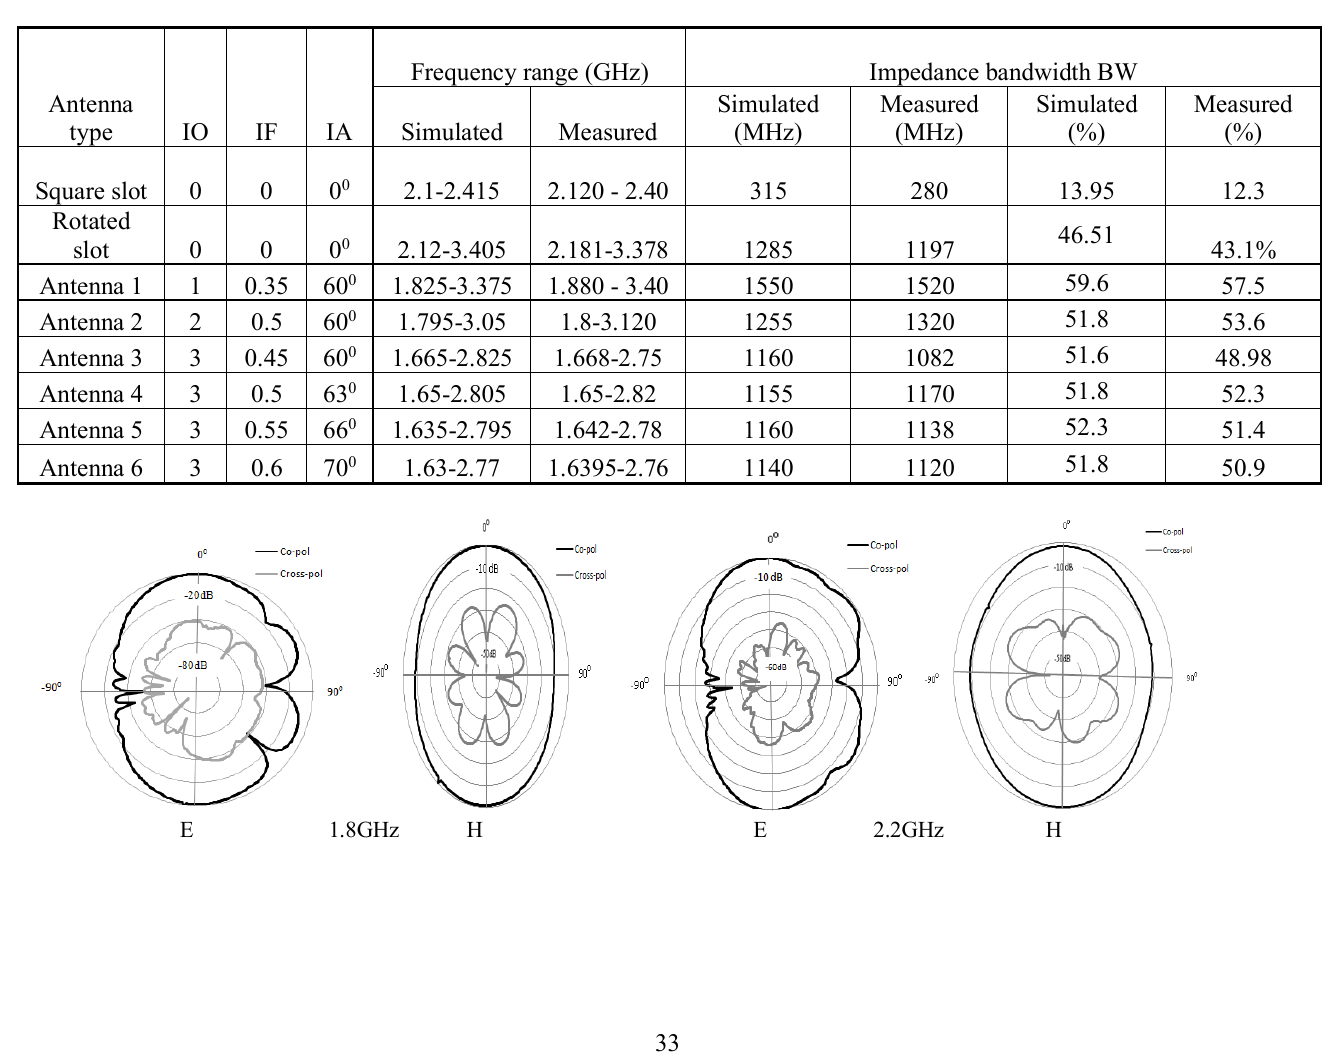
Table 1: Summarized results of the square slot, rotated slot and fractal